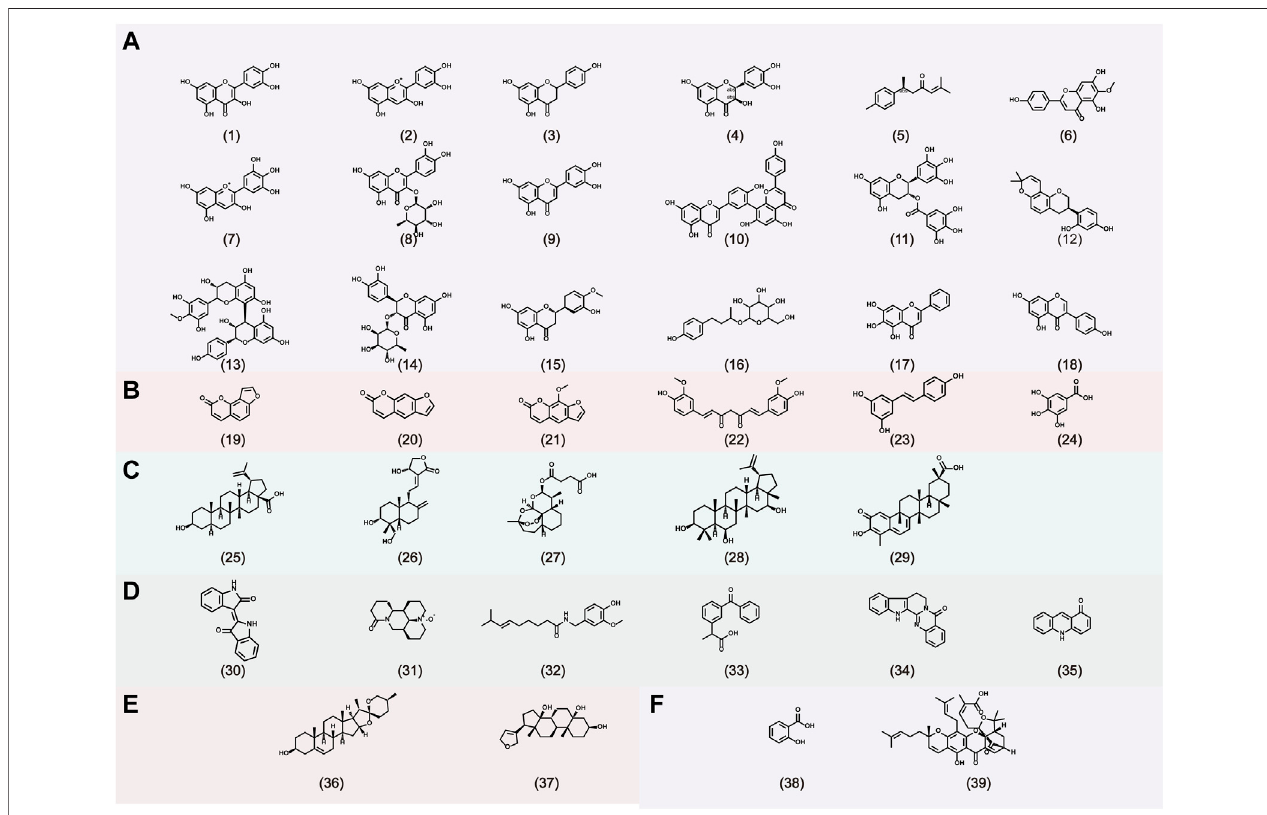
FIGURE3| Thechemicalstructuresofnaturalproductsforthetreatmentofpsoriasis.A:Flavonoids,B:Phenylpropanoids,C:Terpenoids,D:Alkaloids,E:Steroids, F: Organic acids. (1) Quercetin, (2) Cyanidin, (3) Naringenin, (4) Taxifolin, (5) Aromatic-turmerone, (6) Hispidulin, (7) Delphinidin, (8) Quercitrin, (9) Luteolin, (10) Amento fl avone,(11)Epigallocatechin-3-gallate,(12)Glabridin,(13)Proanthocyanidin,(14)Astilbin,(15)Hesperetin,(16)Rhododendrin,(17)Baicalein,(18)Genistein,(19) Isopsoralen, (20) Psoralen, (21) 8-methoxypsoralen, (22) Curcumin, (23) Resveratrol, (24) gallic acid, (25) Betulinic acid, (26) Andrographolide, (27) artesunate, (28) 3 β ,6 β ,16 β -Trihydroxylup-20. (29)-ene (29) Celastrol, (30) Indirubin, (31) Oxymatrine, (32) Capsaicin, (33) Cannabinoids, (34) Rutaecarpine, (35) Acridones, (36) Diosgenin, (37) Periplogenin, (38) Salicylic acid, (39) Gambogic acid.